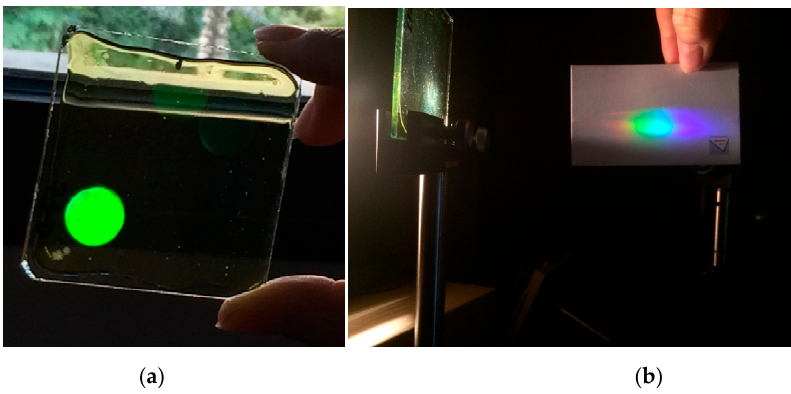
Figure 3. ( a ) Photography of a negative asymmetric volume phase transmission holographic lens observed by reflection illuminated with daylight. A single-color image is observed because it shows by reflection the area in which the evaluated holographic lens is located, ( b ) chromatic dispersion is watching in the same holographic lens working by transmission with a white conjugate collimated beam.